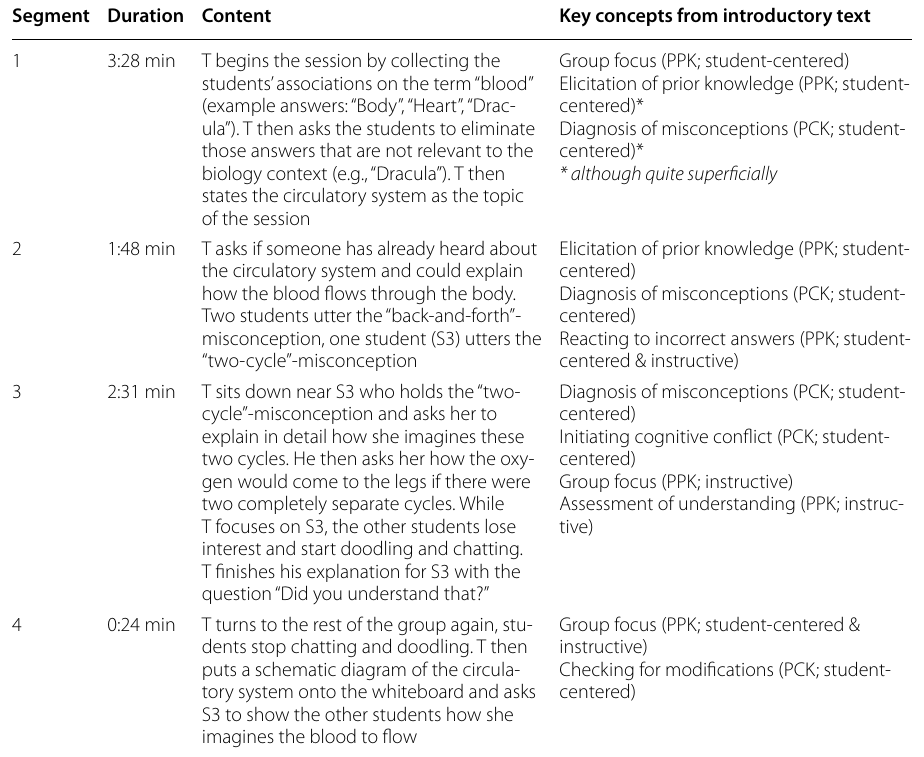
Table 5 Example of a segmented video (brainstorming video) and corresponding key concepts from introductory text one could